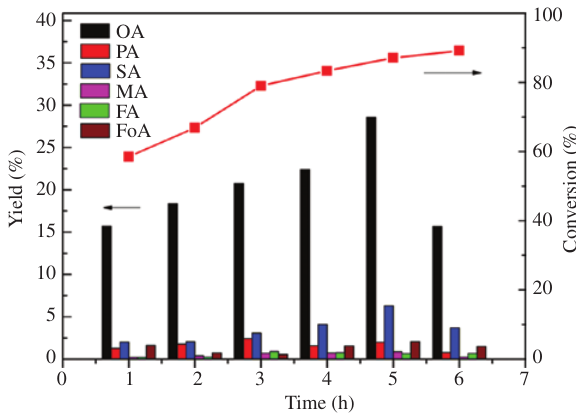
Figure 11: Effect of reaction time on the oxidation reaction.